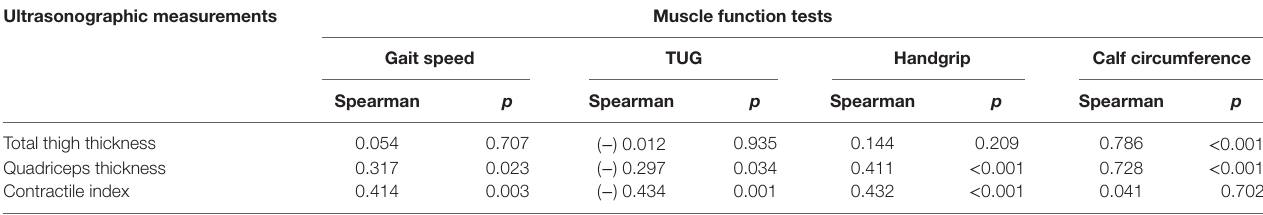
CGA, comprehensive geriatric assessment; TUG, timed up and go